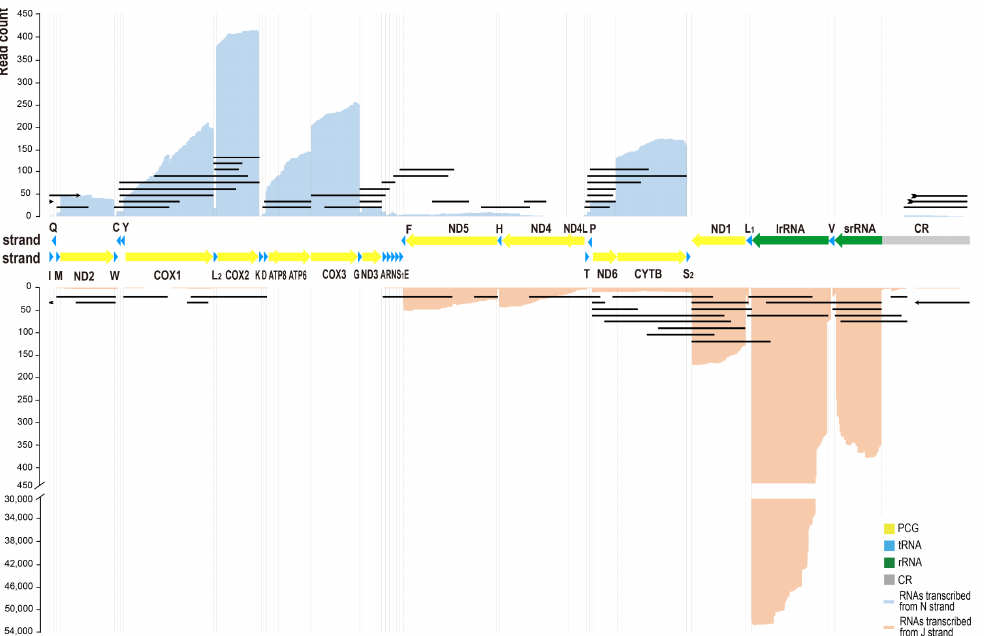
Figure 1. The quantitative transcription map of C. chinensis mitogenome. The mitogenome was arranged in the J strand orientation. Alignments of transcripts encoded by J strand were piled along the positive y-axis in blue color. Alignments of transcripts encoded by N strand were piled along the negative y-axis in orange color. The black lines represent types of polycistronic transcripts, antisense transcripts, and long non-coding RNAs (lncRNAs) from control regions transcribed from N strand (above) and J strand (below). The lines with arrows indicate the same transcript across the control region.